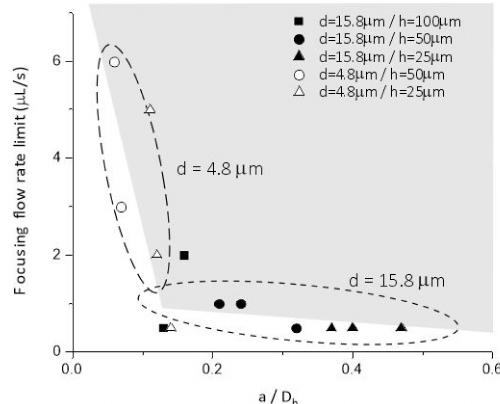
Figure 4. Minimal flow rates necessary for evolution particle focusing states as the function of the a / D h parameter, in case of 4.8 µ m and 15.8 µ m bead diameters as indicated by the dashed circles, respectively.